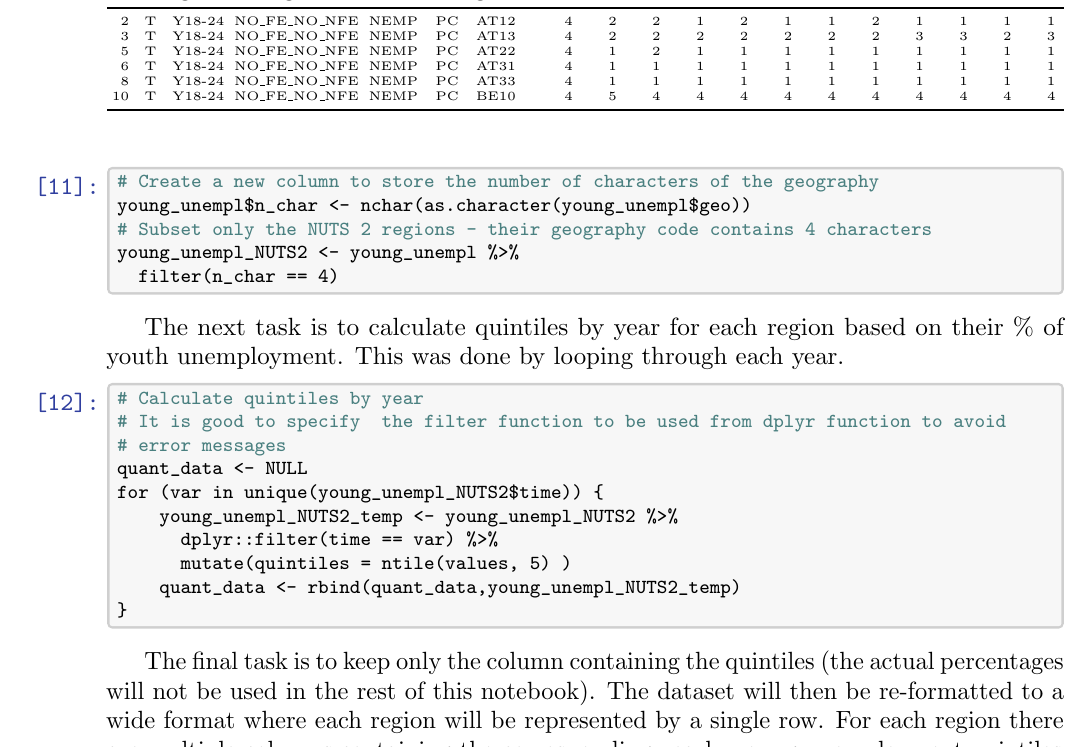
Table 2: Preview of the data that will be used in sequence analysis sex age training wstatus unit geo 2 T Y18-24 NO FE NO NFE NEMP PC